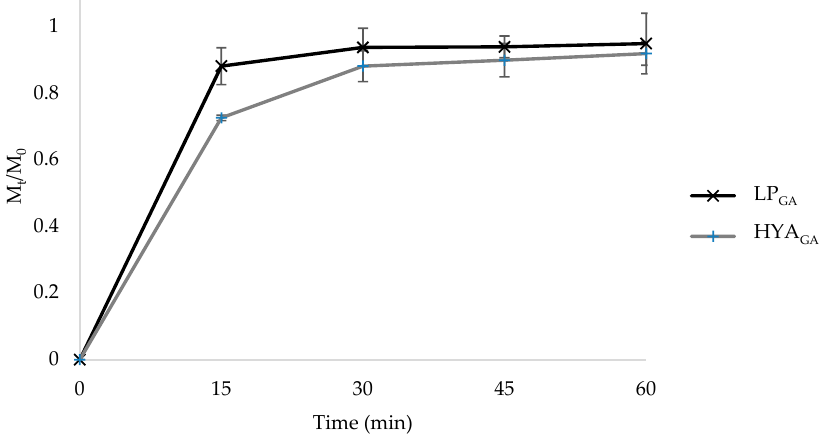
Figure 2. In vitro GA release in PBS / EtOH (7:3 v / v ) from LP GA and HYA GA (mean ± SD, n = 3).